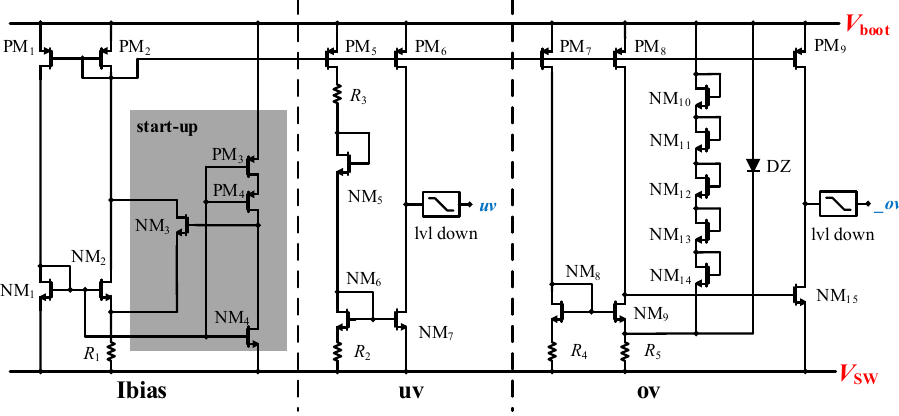
Figure 4. Circuit realization of the proposed TBDC with fully isolated devices.